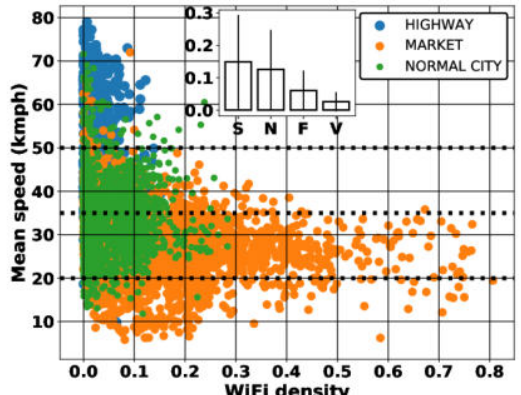
Figure 5. Correlation between Wd and Mean Speed of